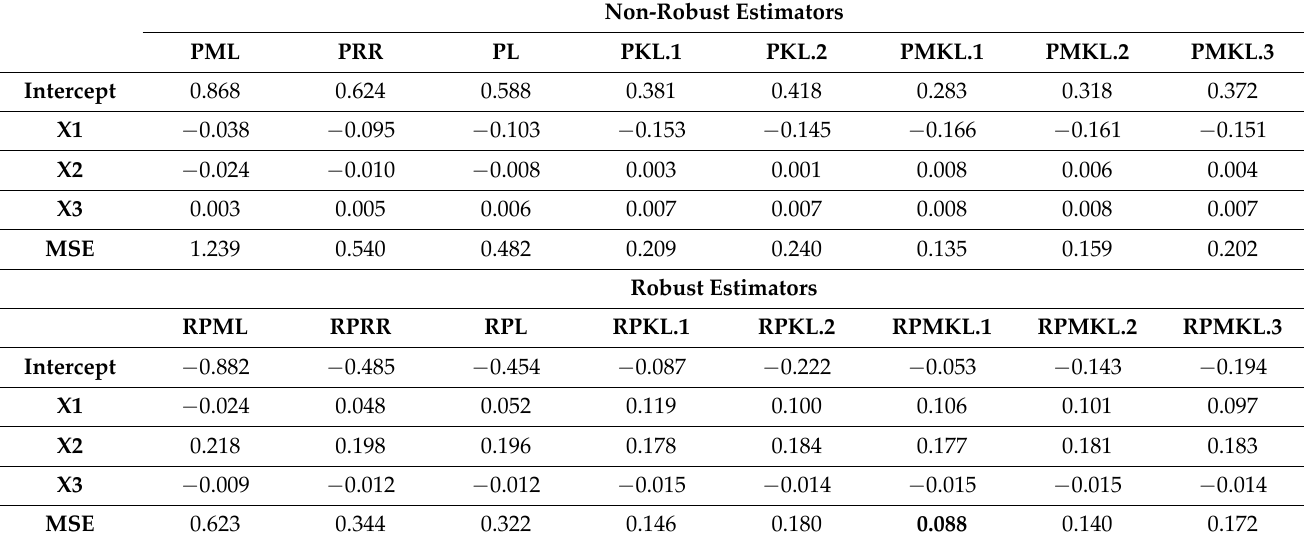
Figure 1. Residuals analysis of the aircraft damage data. Table 1. Estimated coefficients and MSEs of the aircraft damage